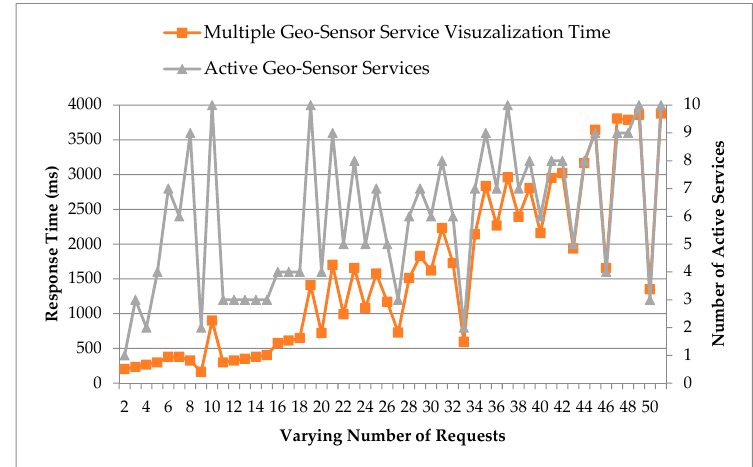
Figure 15. Multiple geo-sensor service access analysis with varying number of requests and varying number of active services.